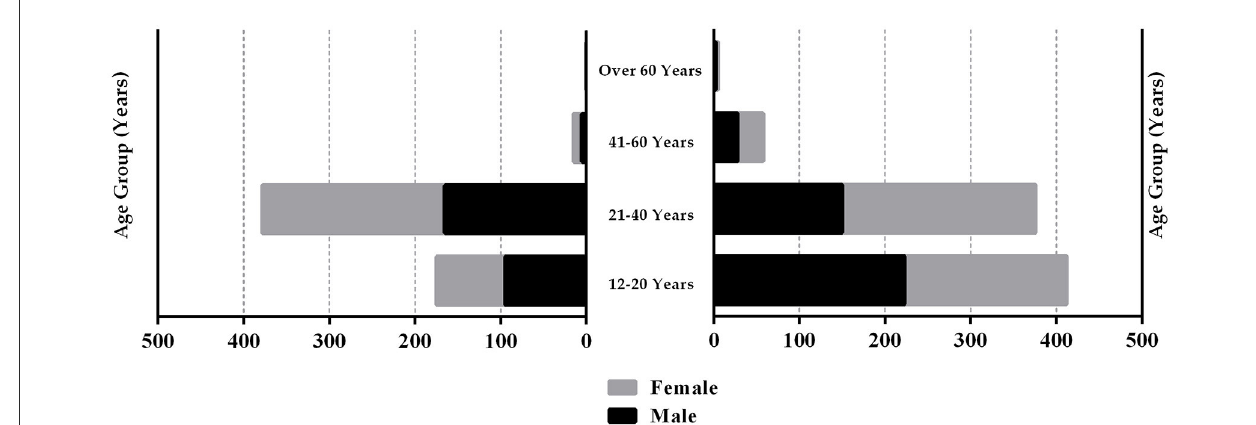
FIGURE1 Histogram detailing the gender split and age ranges for amateur and elite athlete groups.